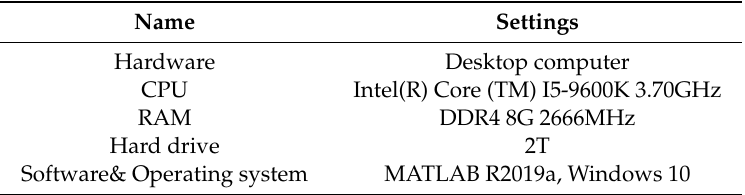
Table 5. Computer configuration.